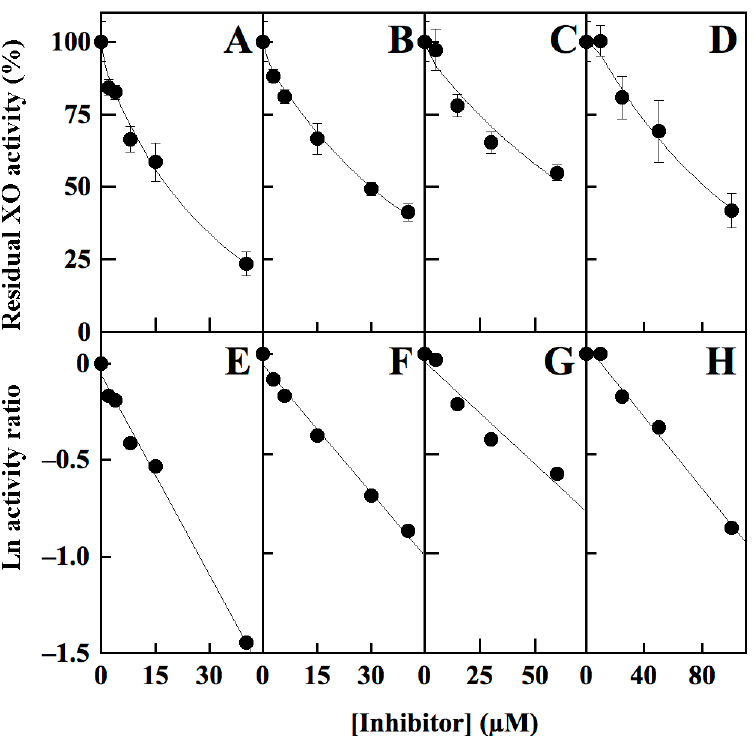
Figure 2. Dose-dependent inhibition profile of xanthine oxidase activity by ALS-28 , -8 , -15 or -1 . The activity of XO (12.5 mU) was measured in buffer A in the presence of 75 µM xanthine through the initial rate of uric acid formation in the presence of the indicated concentration of ALS-28 (panels ( A ) and ( E )), ALS-8 (panels ( B ) and ( F )), ALS-15 (panels ( C ) and ( G )) or ALS-1 (panels ( D ) and ( H )). The activity was expressed either as a percentage of that measured in the absence of inhibitor (panels ( A )–( D )) or as a natural logarithm of the ratio of residual activity (panels ( E )–( H )). Values were reported as the mean ± SE (panels ( A )–( D )); in the logarithmic representation of the data (panels ( E )–( H )), the correlation coefficients R ranged in the 0.966–0.995 interval. Other details are described in Materials and Methods. Table 1. Values of IC 50 obtained from inhibition profiles of structurally unrelated inhibitors of xan- thine oxidase.